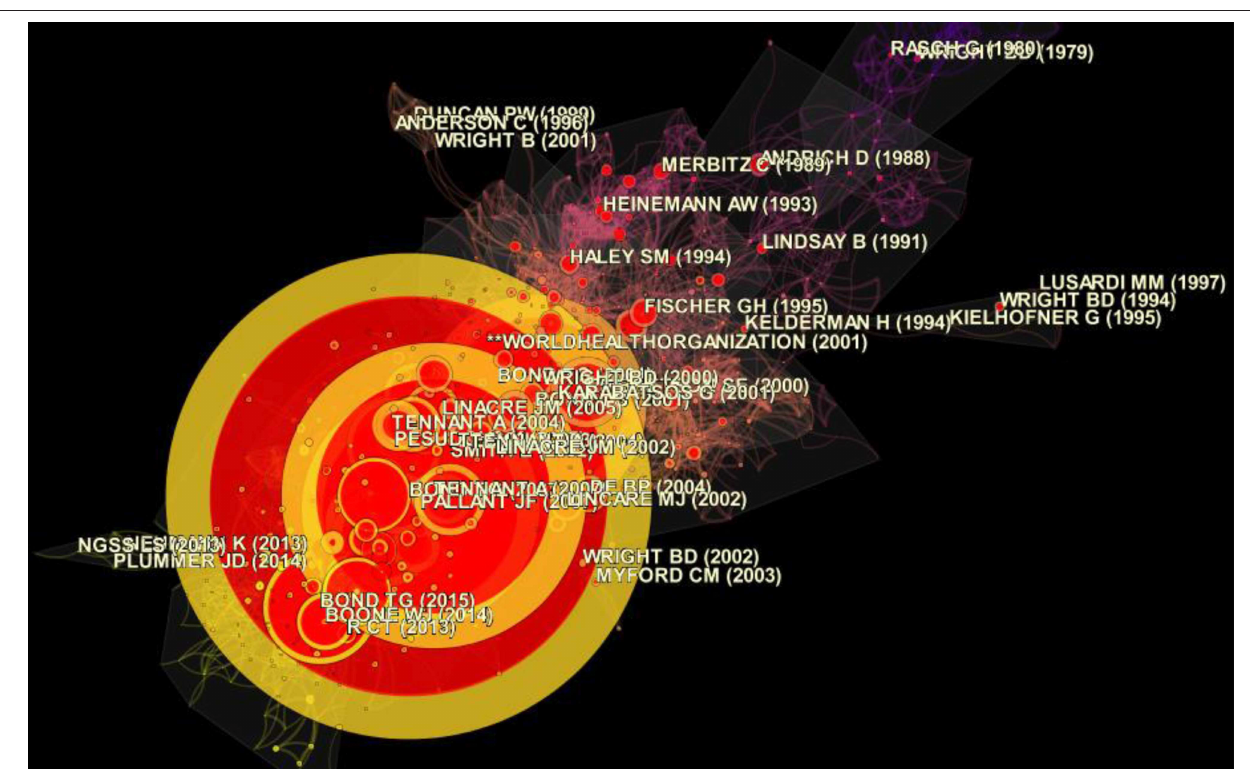
FIGURE 4 | Cluster view of the document co-citation analysis (DCA) network generated by CiteSpace (Chen, 2016a) (modularity Q = 0.7319; average silhouette =